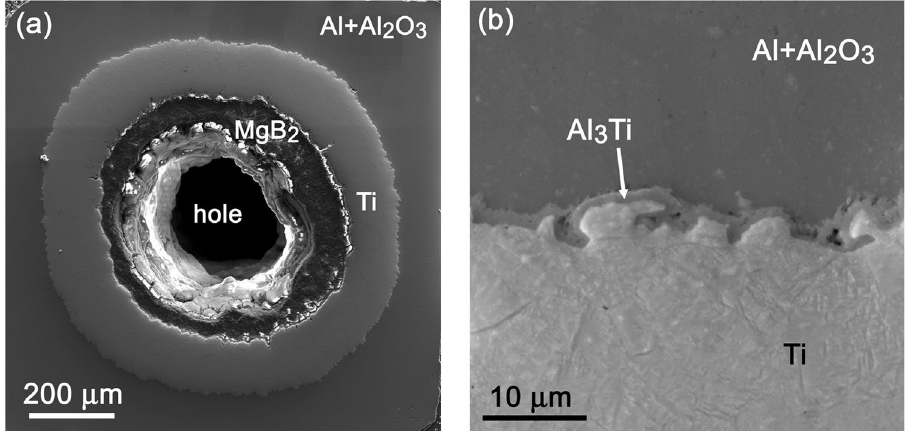
Figure 2. Transversal cross-section image of a heat-treated wB wire ( a ) and a detail of an Al 3 Ti reaction layer at the Ti/Al interface of the wB wire ( b ).